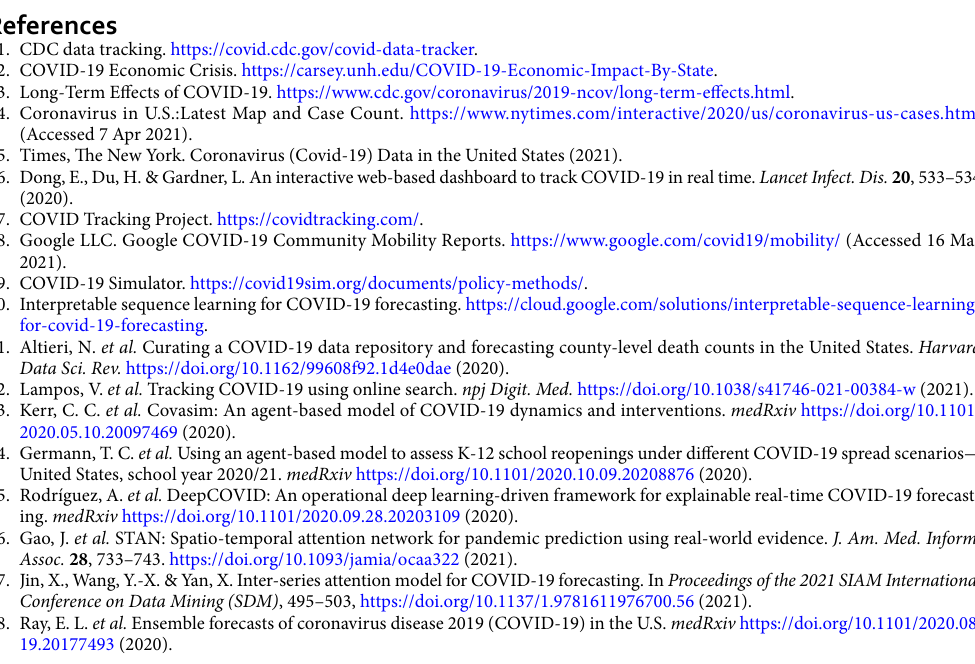
model and the Mixup model. COURAGE takes the average of both predictions from the County model and the Mixup model as its prediction. Our baseline model is a Naive model that takes the current week total number of deaths as both Week 1 and Week 2 total number of deaths predictions. For the state-level prediction task, we have another baseline model—a State model that uses only state-level data as input when making the predictions.